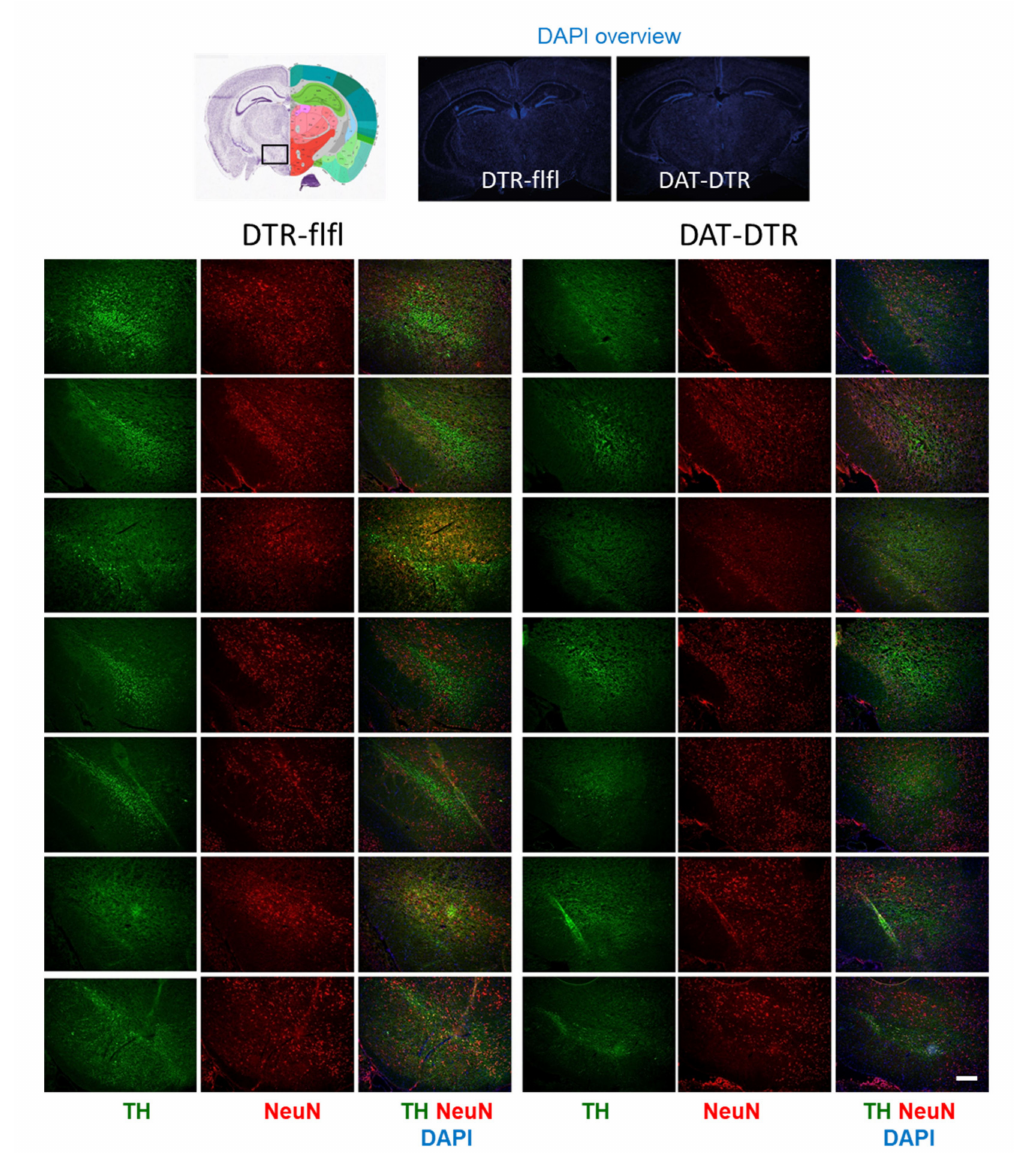
Figure 2. Immunofluorescence analysis of tyrosine hydroxylase (TH) as a marker for DA neurons in the substantia nigra (SN). The pan-neuronal marker NeuN was used to label all neurons. DAPI was used as counterstain of nuclei. Mice were treated with 5 × 0.1 ng/g DTx. Mice were 9–13 weeks old at the onset of DTx and were sacrificed 6–7 weeks after the last DTx dose. The image shows examples of n = 4–6 mice per group (one side or both sides). Scale bar 200 µ